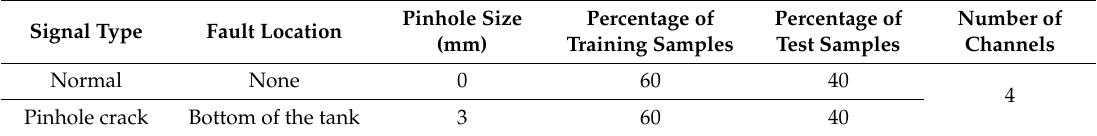
Table 3. Dataset